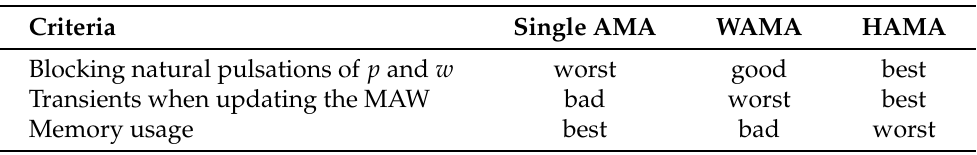
Table 3. Assessment of three CPT transducers using either single AMAs with rounded MAWs, WAMAs, or